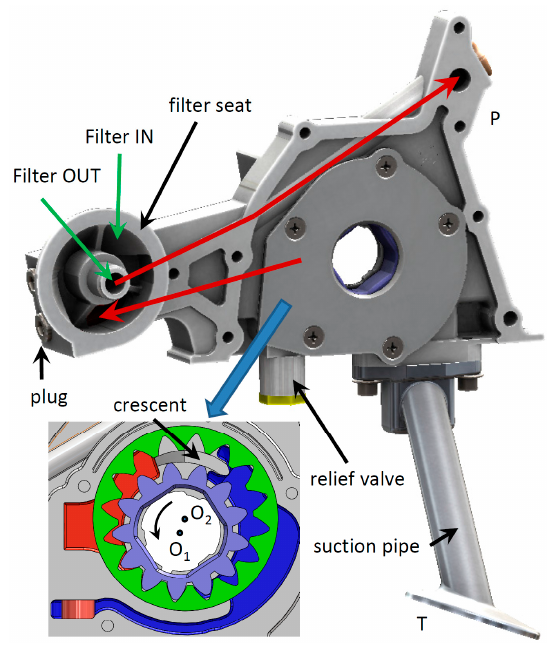
Figure 1. 3D drawing of the crescent pump under study with the indication of flow path (red lines).